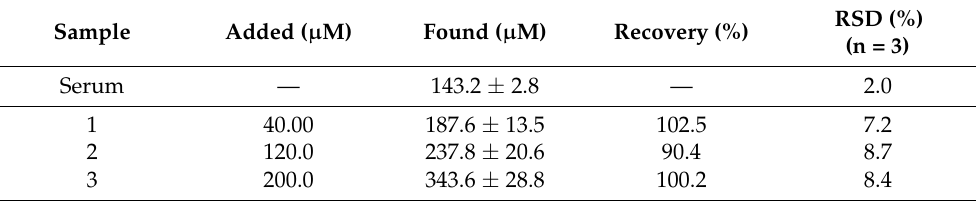
Table 2. Recovery of lactate in human serum with Alg@MFM@QDs-LOx MSs.